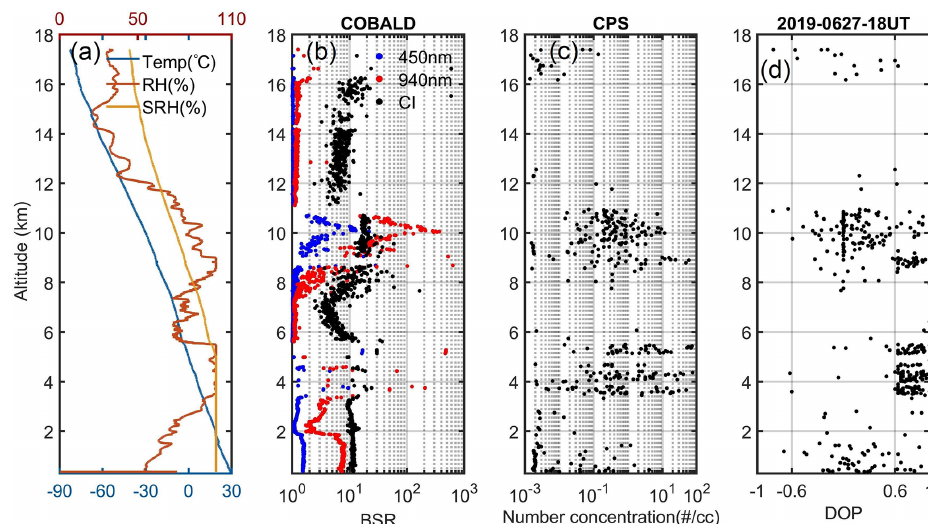
Figure 10. Combined observations of COBALD and CPS from balloon sounding held on 27 June 2019 at 23:30LT: (a) temperature ( T ), relative humidity (RH), and saturation relative humidity (SRH); (b) backscatter ratio at 455nm (blue) and 940nm (red) and colour index (black); (c) cloud particle number concentration; and (d) degree of polarization